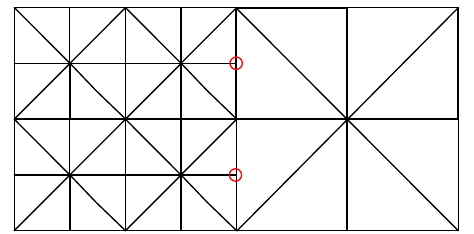
Figure 3. Attaching different level of detail tiles results in cracks